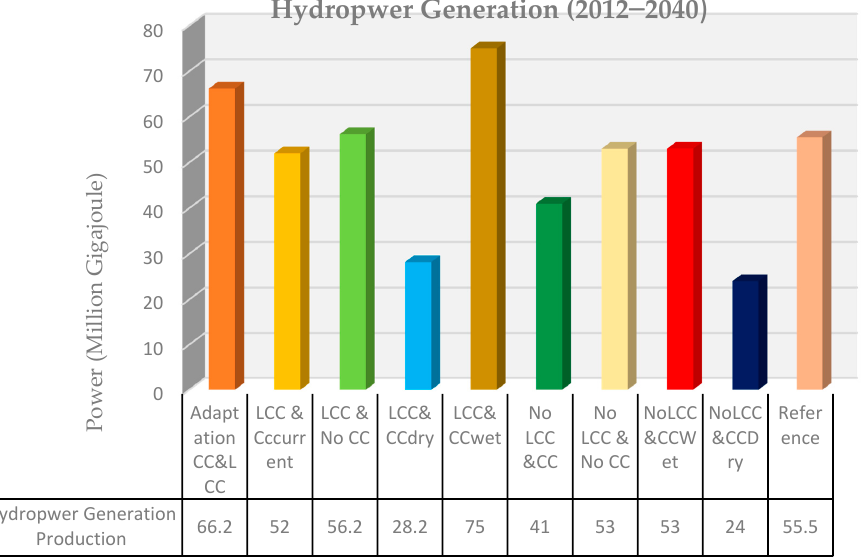
Figure 7. Power generation.